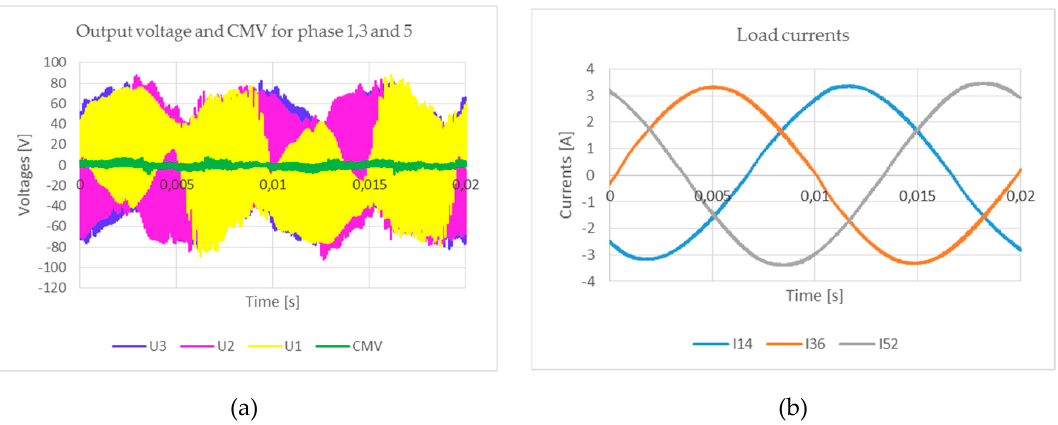
Figure 15. Waveform of the output phase voltages for phase 1,2 and 3 (dark blue, pink, yellow) and the CMV (green) ( a ), load currents ( b ), synthesized in the MC controlled by the use of the CW rotating space vectors for three ‐ phase open ‐ end load and output frequency of 50 Hz.